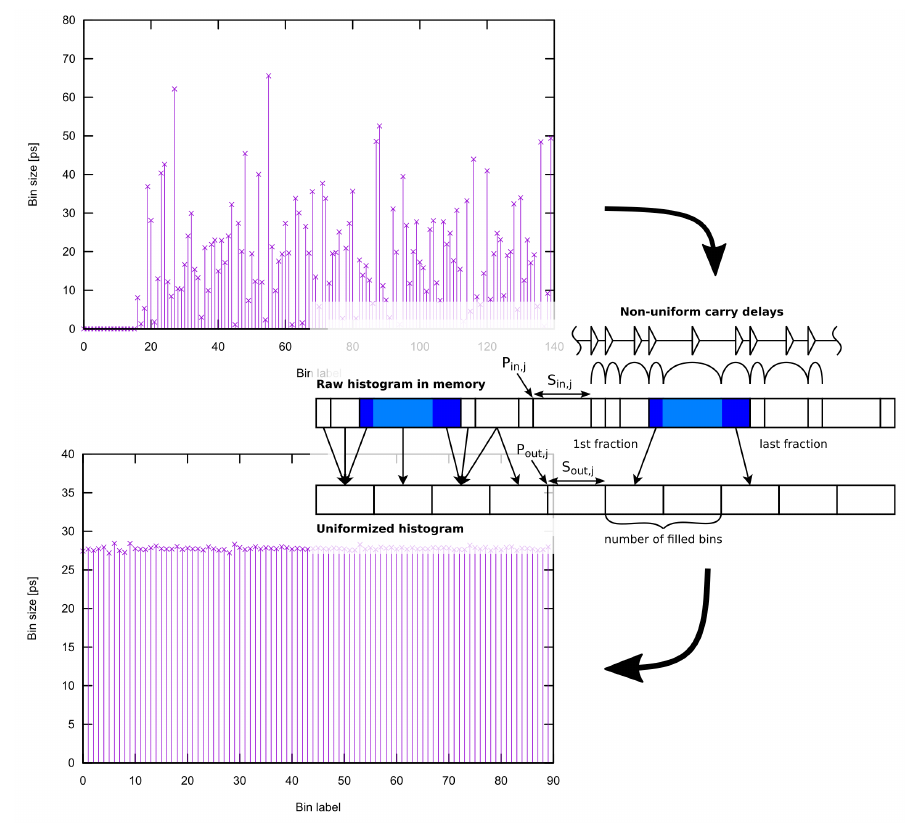
Figure 5. Two density measurements before and after histogram equalization with a schematic representation of the post-processing. The post-processing module is programmed with a compressed representation of the correction matrix for each TDC such that it is capable to correct non-linearities during readout in real-time. The most prominent non-linearity in the input histograms corresponds to unused bins from code 0 to the earliest samples. They occur because the delay line is longer than the sampling period, such that not all codes are used. Each TDC has a different number of unused